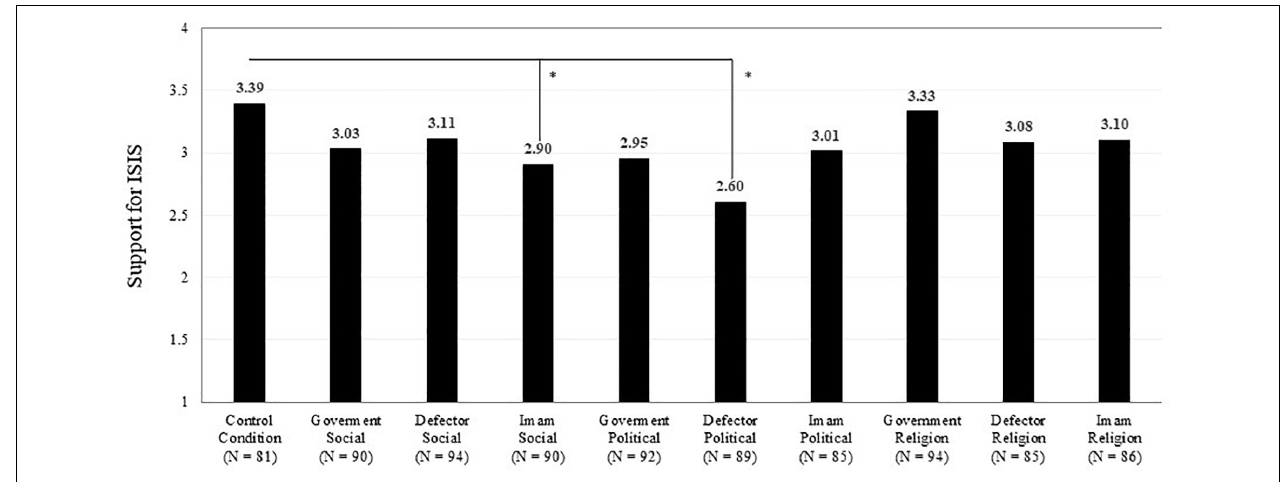
FIGURE 1 | Support for ISIS across experimental conditions ( N = 886). *p <